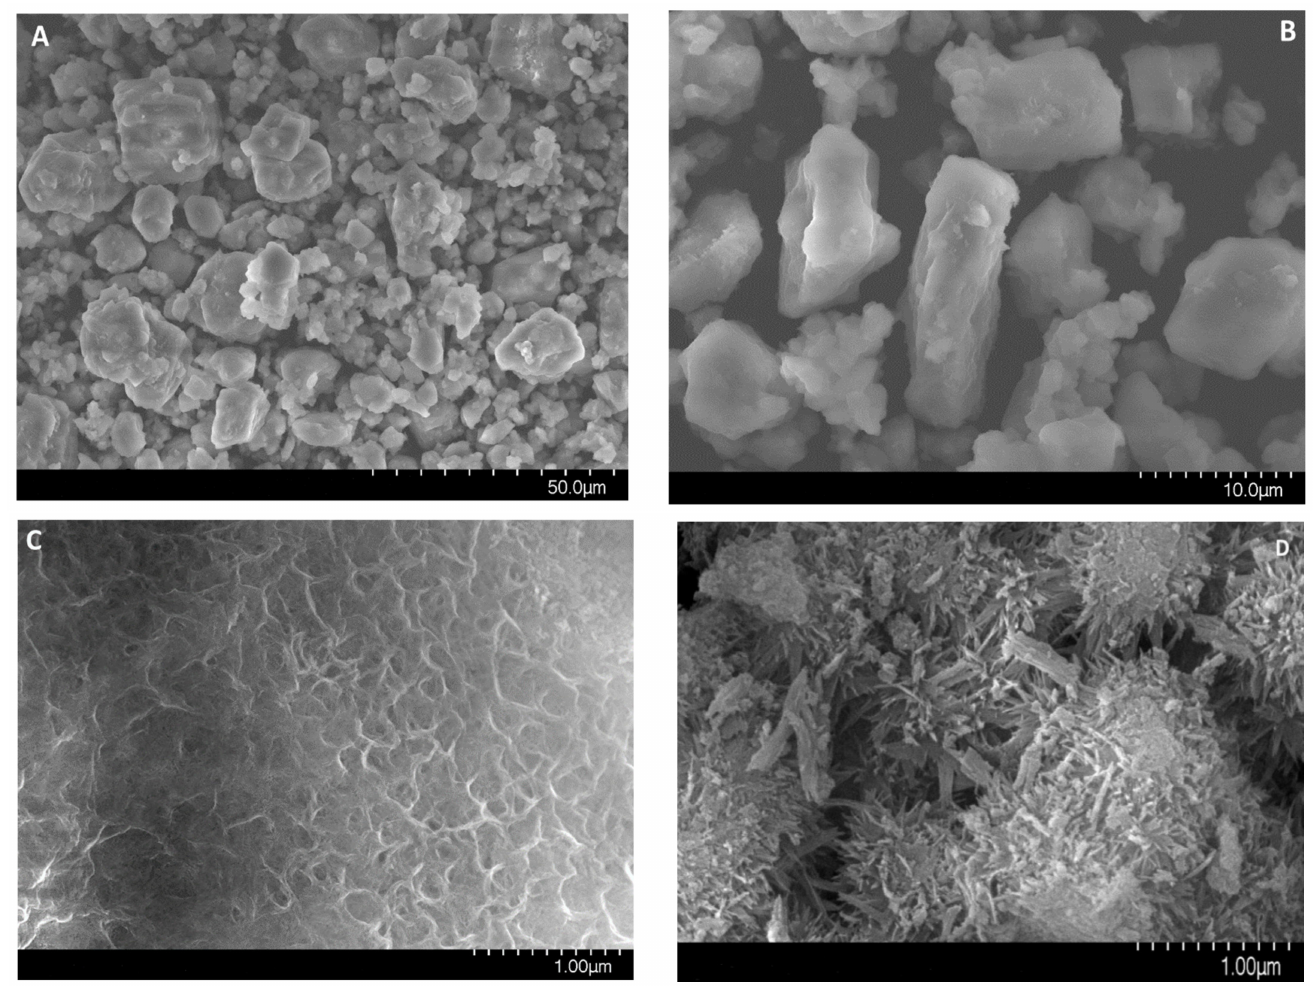
Figure 3. Electron microscopy images of MgAl(1)-550 ( A – C ) and MgAl(2)-550 ( D ) samples. Electron microscopy images in Figure 3A–C demonstrate the formation of spherical aggregates with a size from 2 to 40 µ m in the tested MgAl(1)-550 sample. Morphological differences between the samples are related to the texture of aggregates. Aggregates in the MgAl(2)-550 sample are made of needle-like particles, as in Figure 3D, whereas in the MgAl(1)-550 sample, the needle-like particles are observed only on the surface and their diversity is much smaller than in the MgAl(2)-550 sample, as in Figure 3B. In addition, according to the elemental composition identified by energy-dispersive X-ray spectroscopy at a probe electron energy up to 25 keV for different regions of MgAl(1)-550 particles, the average weight ratio of Al/Mg was ca. 3.5, which exceeds the stoichiometric ratio typical of spinel and testifies to a lower content of magnesium in the subsurface layer of particles in this sample. Since the presence of a magnesium oxide phase is observed in the sample, it can be represented by individual particles. The obtained quantitative data on the total magnesium content and Al/Mg weight ratio, as well as the XRD data, give grounds to estimate the total content of magnesium oxide phase in the MgAl(1)-550 sample as ca. 10